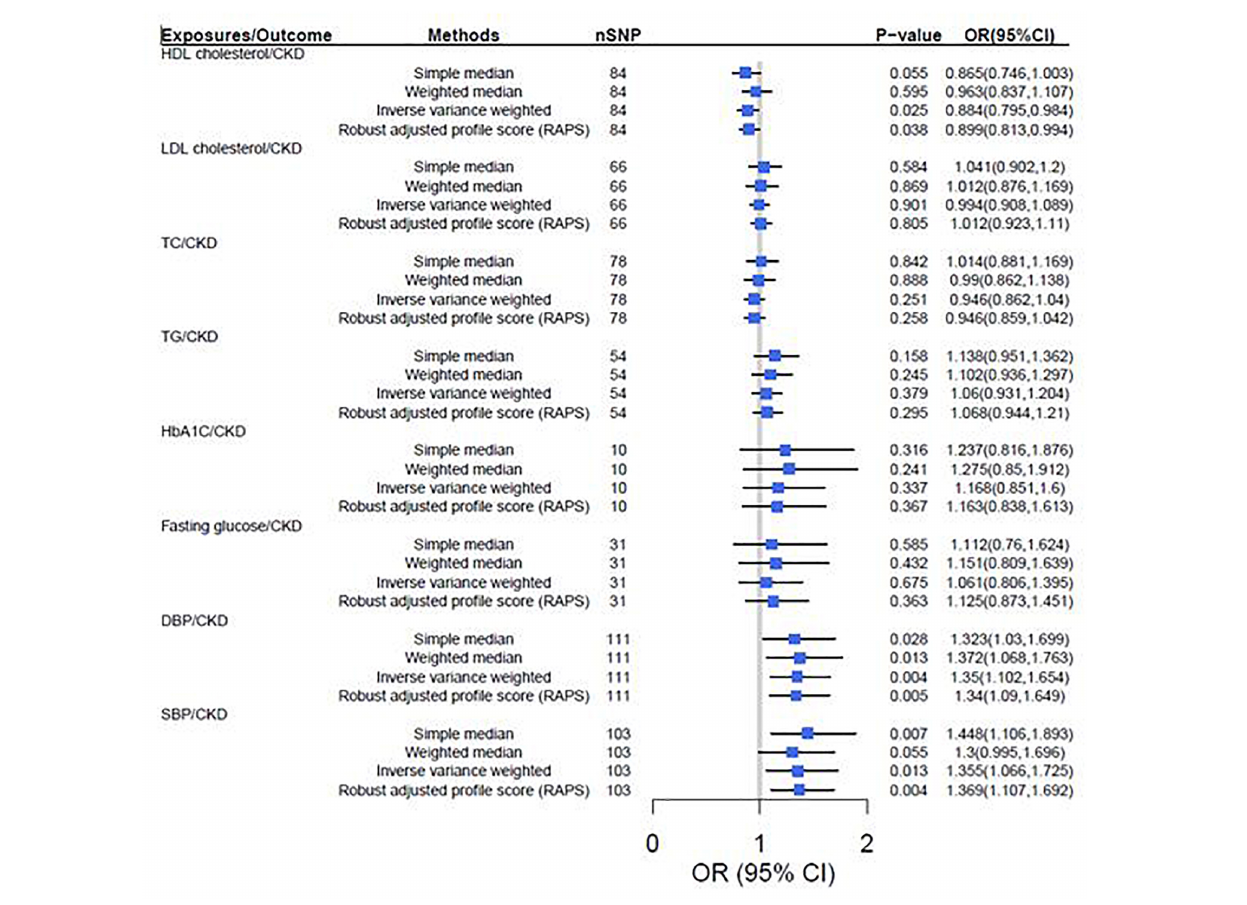
FIGURE 2 | Two-sample mendelian randomization of cardiovascular risk factors and the risk of CKD. CKD was defined as eGFRcrea < 60 mL/min/1.73 m 2 . We used the 1 SD value from HDL cholesterol, LDL cholesterol, TC, TG, HbA1c, fasting glucose, SBP and DBP GWAS summary-level statistics. Results are standardized to a 1-SD increase in exposures; CI, confidence interval; HDL, high density lipoprotein; IVs, instrumental variables; CKD, chronic kidney disease; LDL, low density lipoprotein; TC, total cholesterol; TG, triglyceride; SBP, systolic blood pressure; DBP, diastolic blood